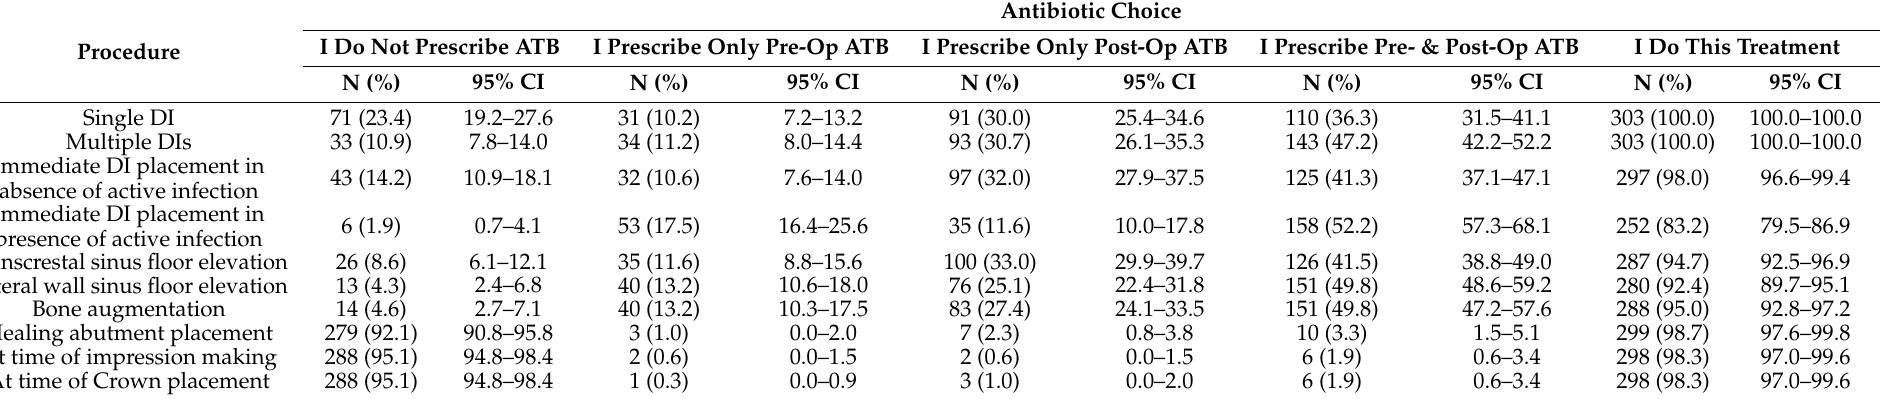
Table 2. Antibiotic prescription choices in different dental implant procedures in healthy patients.